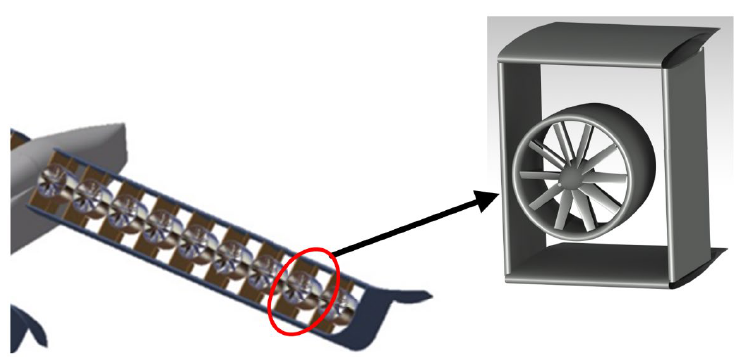
Figure 1. Typical composition of DFW unit.